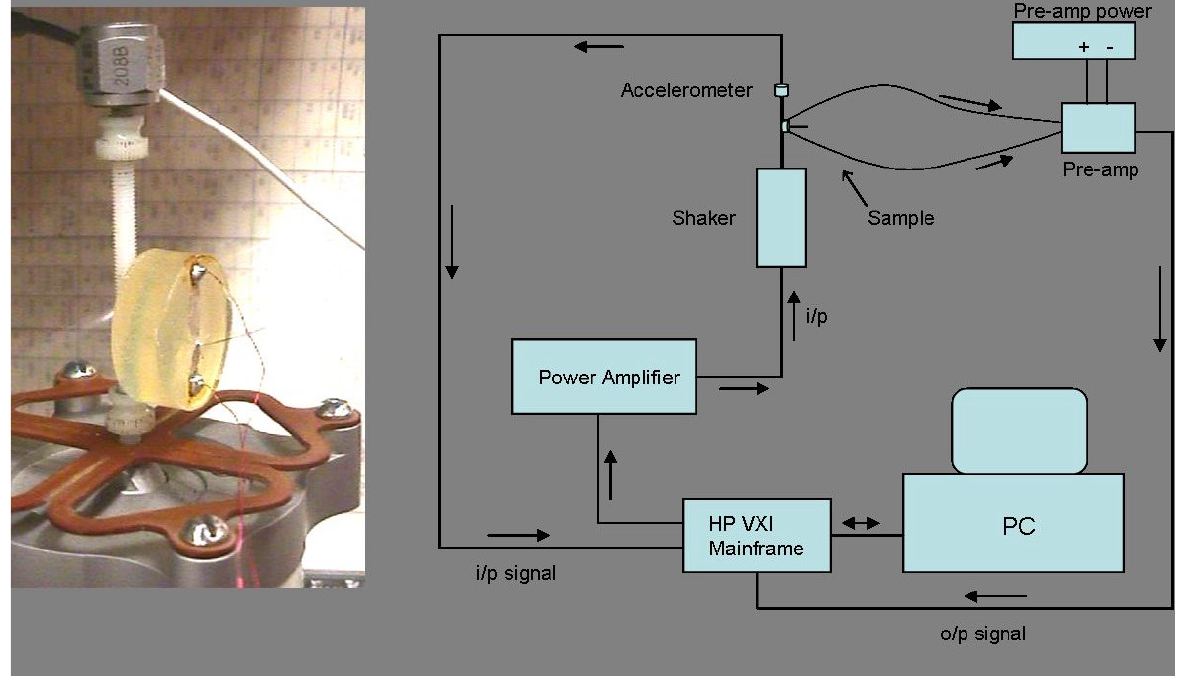
Figure 1 . Photograph and schematic of experimental